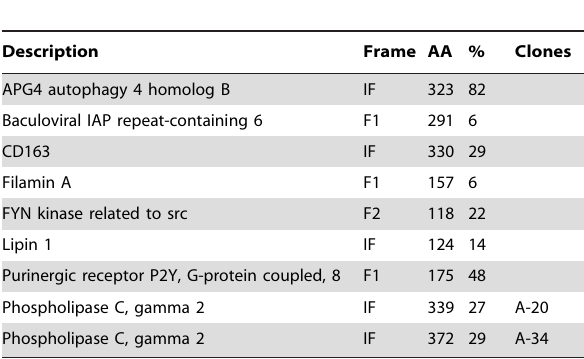
Table 1. Clones isolated in the yeast two-hybrid screen using the full-length